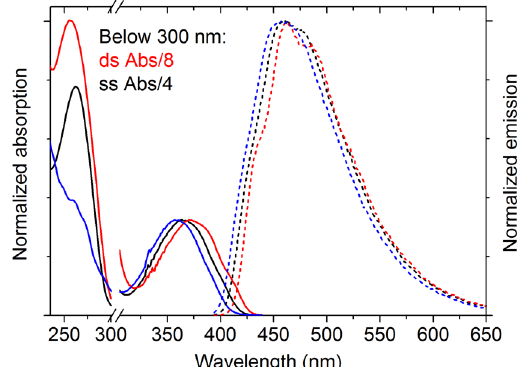
Figure 3. Isotropic absorption (solid) and emission (dashed) spectra of the tC O -monomer (blue), tC O - containing RNA single strand (AU, black) and tC O -containing RNA duplex (AU, red). For better comparison of spectral envelopes, the spectra have been normalized at the maxima of the lowest energy absorption band (left) and of the emission (right),